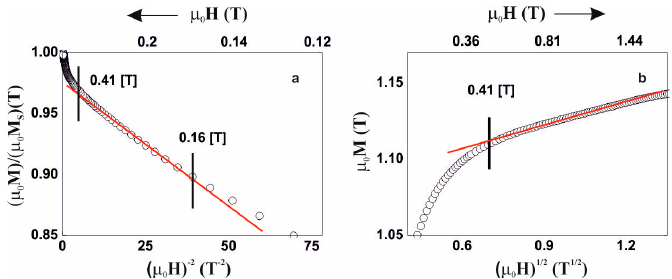
Figure 8. Magnetisation for the alloy Fe 43 Co 29 Y 8 B 20, as a function of: ( a ) (µ 0 H) − 2 , ( b ) (µ 0 H) 1/2 .